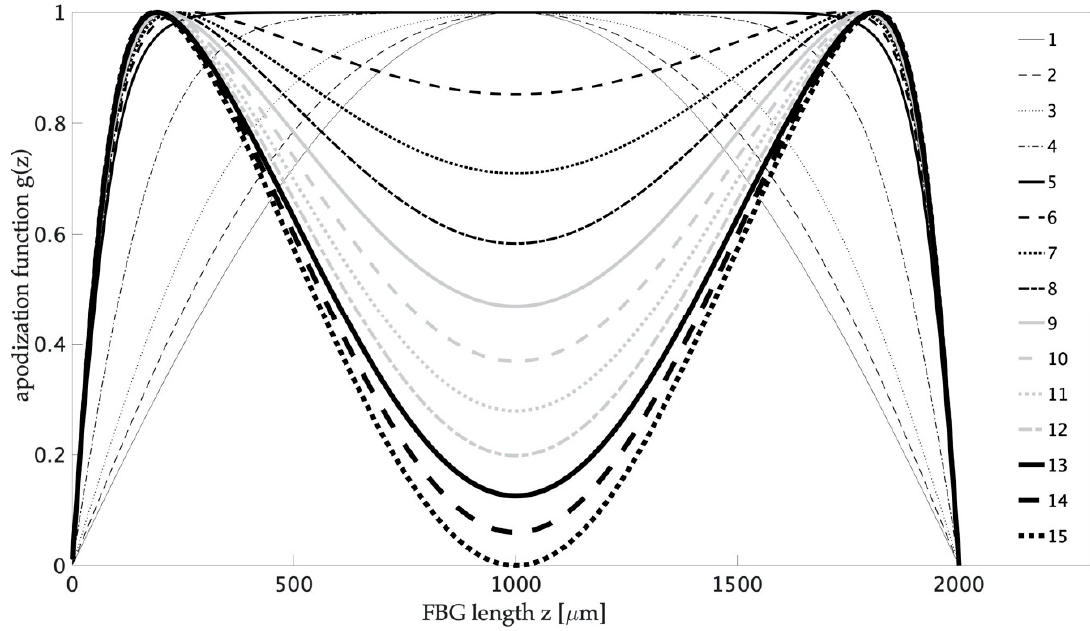
Figure 2. Apodization profiles used in numerical modeling of fiber Bragg gratings (FBG) spectral characteristics.